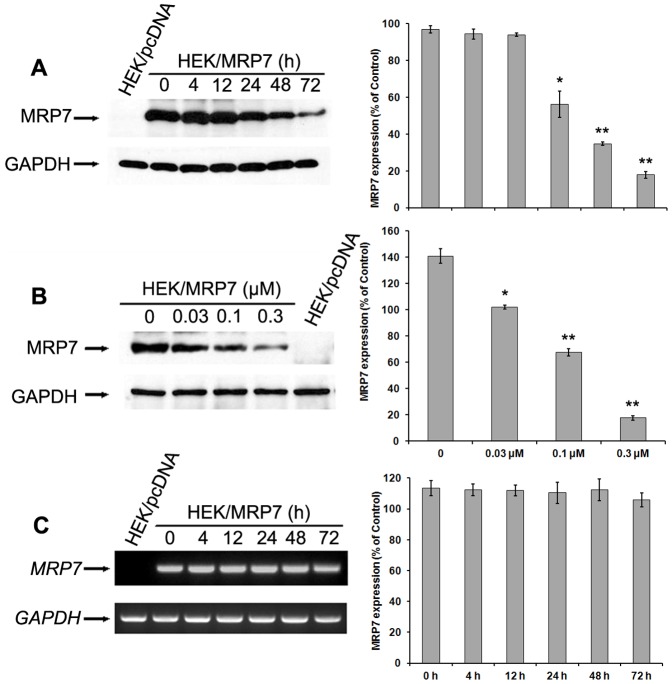
Effect of tariquidar treatment on protein and mRNA expression of MRP7 in HEK/pcDNA and HEK/MRP7 cells.(A) The effect of 0.3 µM tariquidar treatment on the protein expression of MRP7 in HEK/pcDNA and HEK/MRP7 cells at 0, 4, 12, 24, 48 and 72 h. (B) The effect of 72 h tariquidar treatment at difference concentrations on the protein expression of MRP7 in HEK/pcDNA and HEK/MRP7 cells. (C) mRNA levels of MRP7 in HEK/pcDNA and HEK/MRP7 cells treated with 0.3 µM tariquidar at different time points. GAPDH was used as a loading control. The protein or mRNA levels of MDR7 were normalized to those of GAPDH and shown on the right. Results are represented as mean ± SD. P values were obtained using analysis of variance by comparing the relative amounts of protein or mRNA in cells treated with tariquidar with those in untreated control cells. Results representative of 3 independent experiments are shown. *: P<0.05; **: P<0.01.